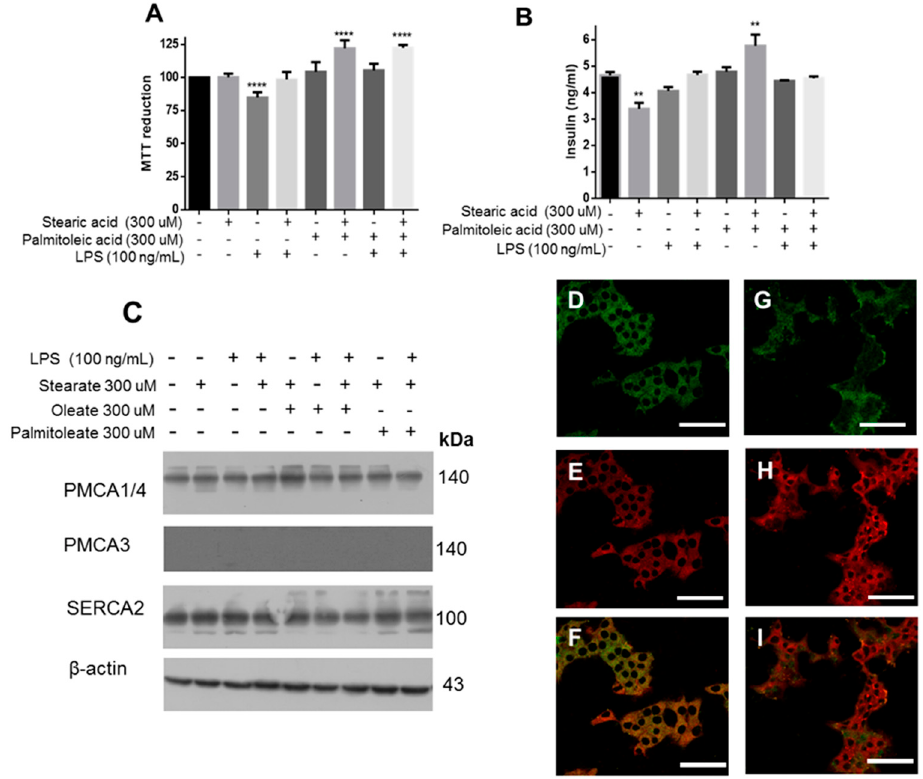
Figure 8. Stearic acid does not modify the homeostasis of calcium in β -cells. ( A) Viability assay experimentation under treatment with different fatty acids. **** p < 0.01 with respect to control ( n = 6, mean ± SD). ( B ) Determination of insulin concentrations in supernatant medium. ** p < 0.05 with respect to control ( n = 3, mean ± SD). ( C ) Expression of targets that regulate the intracellular calcium concentration. β -actin was used as a loading control. Confocal images of β -cells treated with BDP-PA ( D ), Aza-2-BDP ( E ) and the merge ( F ). Under the same conditions, β -cells treated with BDP-SA ( G ), Aza-2-BDP ( H ), and the merge ( I ). Bars correspond to 50 µm.